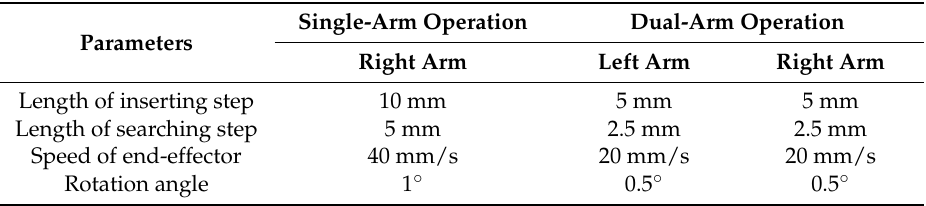
Table 3. Parameters for single-arm operation and dual-arm operation.